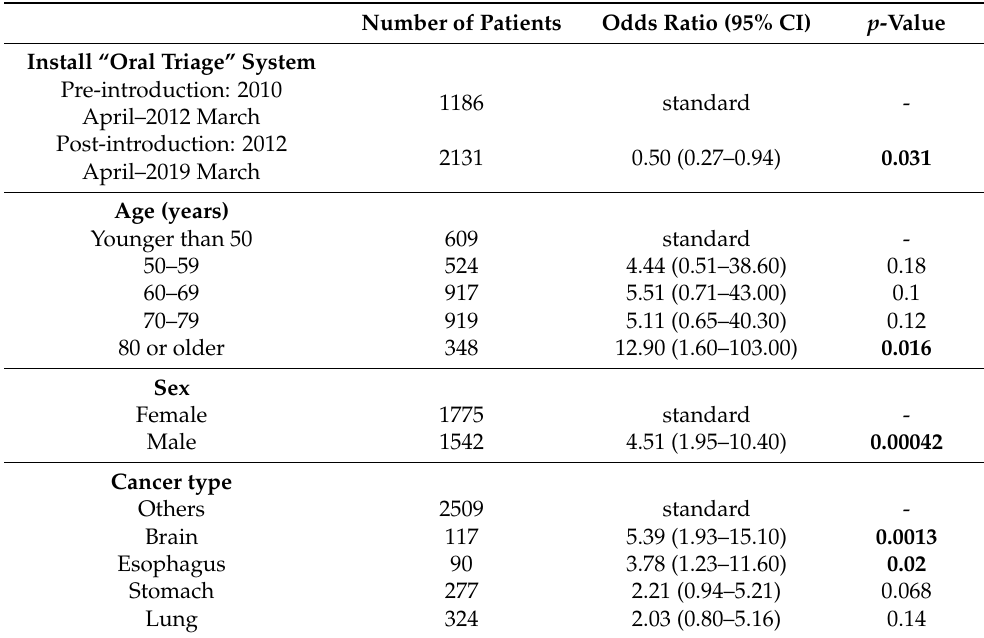
Table 5. Risk factors for postoperative pneumonia in the target group by logistic regression